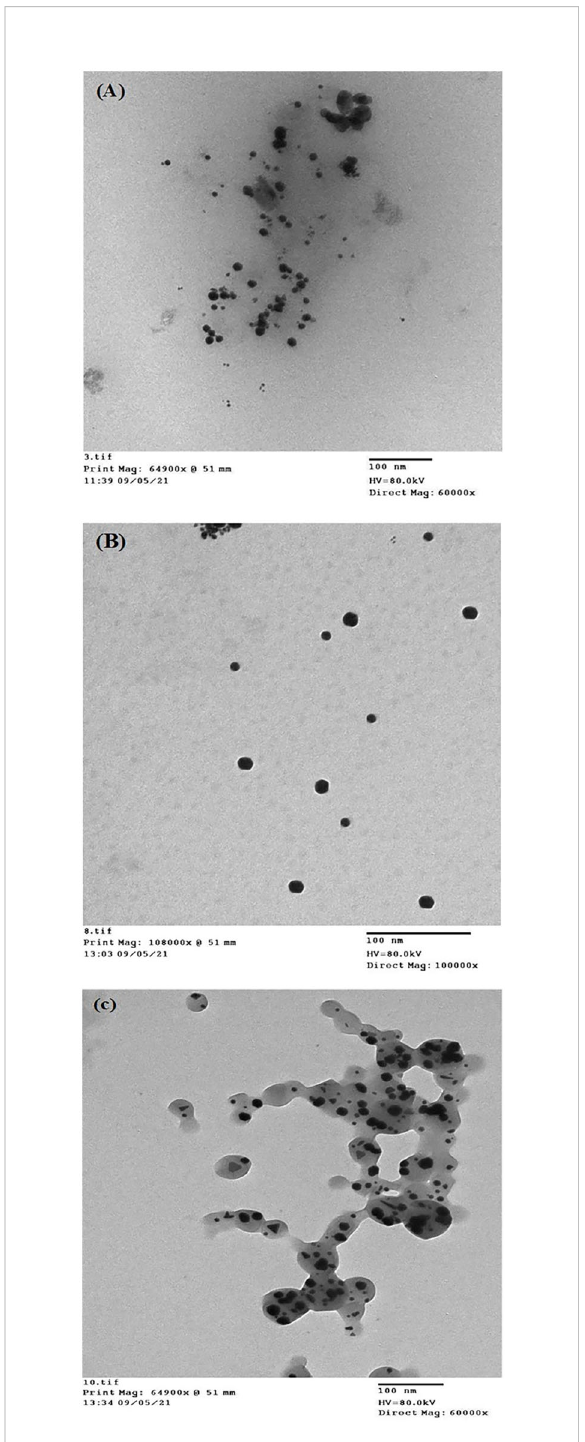
FIGURE 6 TEM micrograph of Au-NPs biosynthesized using the extracts of macroalgae (A) C. myrica , (B) C. trinodis , and (C) C. prolifera